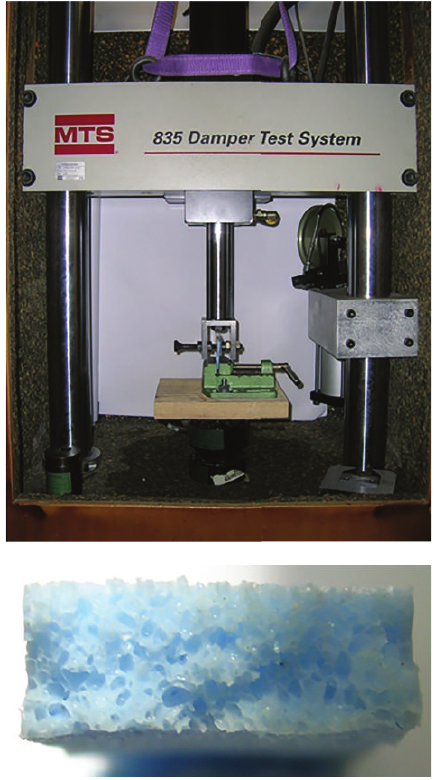
Figure 5: MTS 835 Damper Test System and result from a traction test carried out with porous